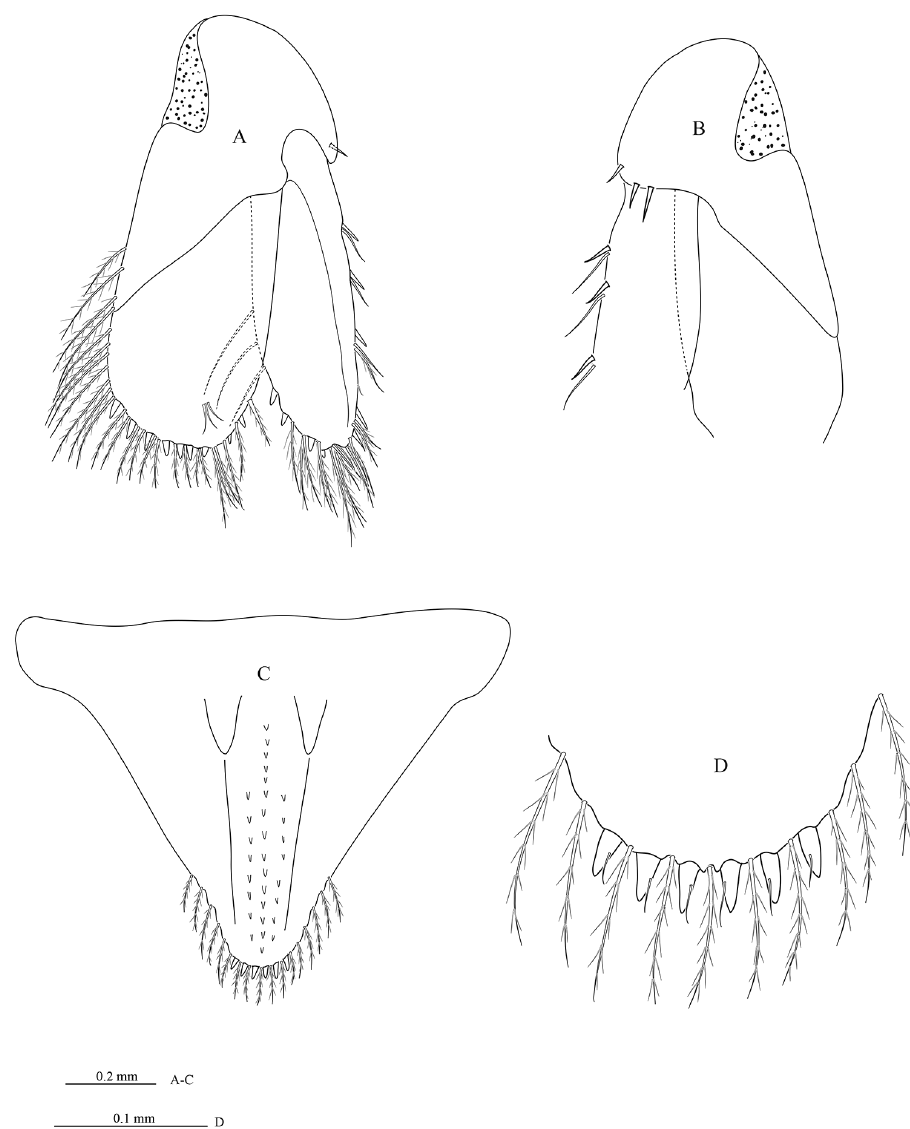
Figure 6. Cirolana phuketensis sp. n., male paratype (PSUZC–CR0286-02) (5.1 mm) A uropod B ven- tral view of uropod peduncle and exopod C pleotelson D pleotelson apex.